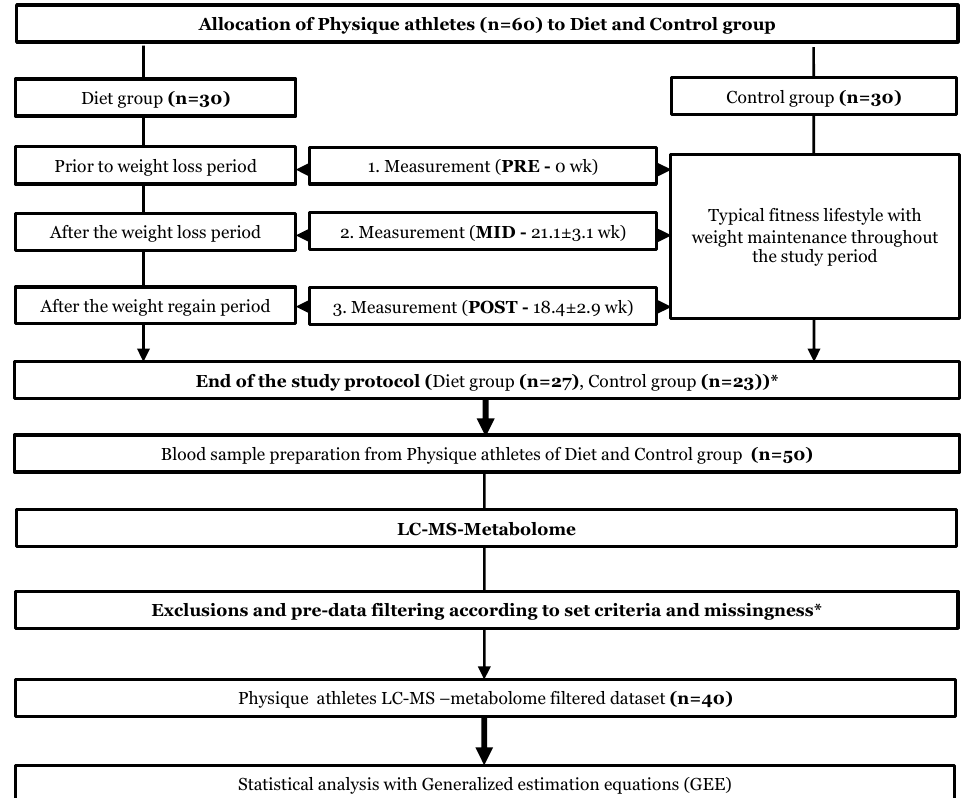
Figure 1. Study design and workflow. Study design and workflow are represented as flowchart to illustrate the whole study protocol. The upper part of the flowchart describes the weight loss and weight regain period of the diet group. In the lower part, we depict the following omics analysis protocol used in the current study. * Of the total 60 participants who started the study, a total of 10 athletes failed to complete the study regimen. In addition, one control did not arrive for baseline testing (PRE), and remaining 9 ( n = 3 dieters, n = 6 controls) participants were excluded due to two reasons (i) short duration of the weight regain period compared with the other participants or (ii) failure to completely follow the study instructions. Additional participants who lacked complete dietary records ( n = 8) were excluded from the current omics study. In addition, from the n = 42, two individuals did not have information on LC-MS metabolomics, resulting in the final sample of n = 40 physique athletes that were examined in this study. Furthermore, the sample size varied slightly between different downstream analyses due to incompleteness of omics or phenotype